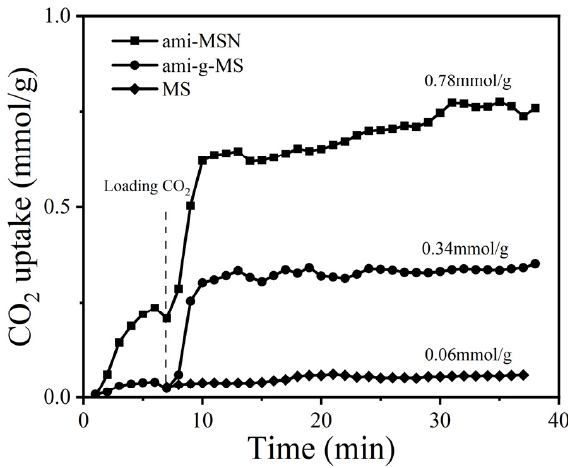
Figure 6. Dynamic CO 2 adsorption capacity of the materials.